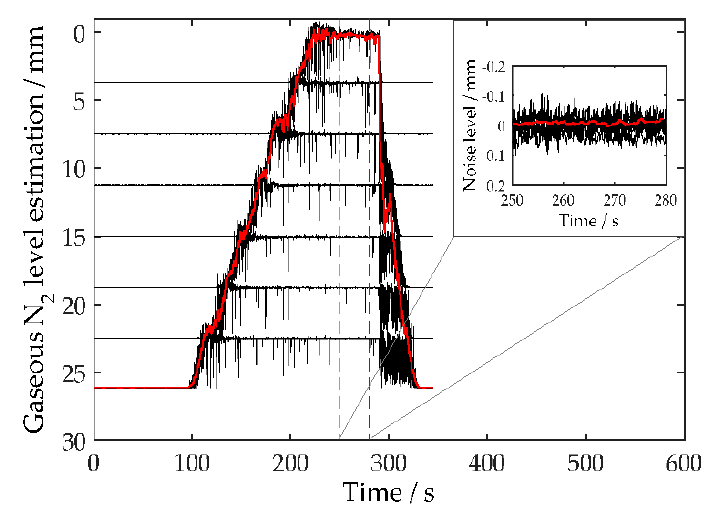
Figure 4. Gas level from the transmission measurement in LN 2 (black curve: unfiltered data, red curve: filtered data) during linear emptying and filling procedure of the trap with N 2 .